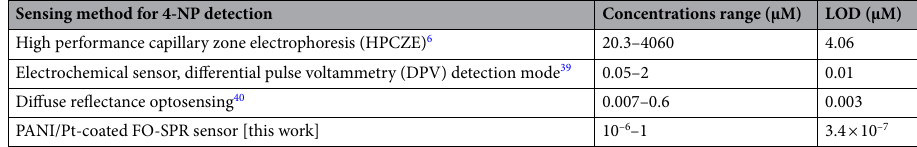
Table 3. Synopsis of the 4-NP detecting performance by alternative sensing